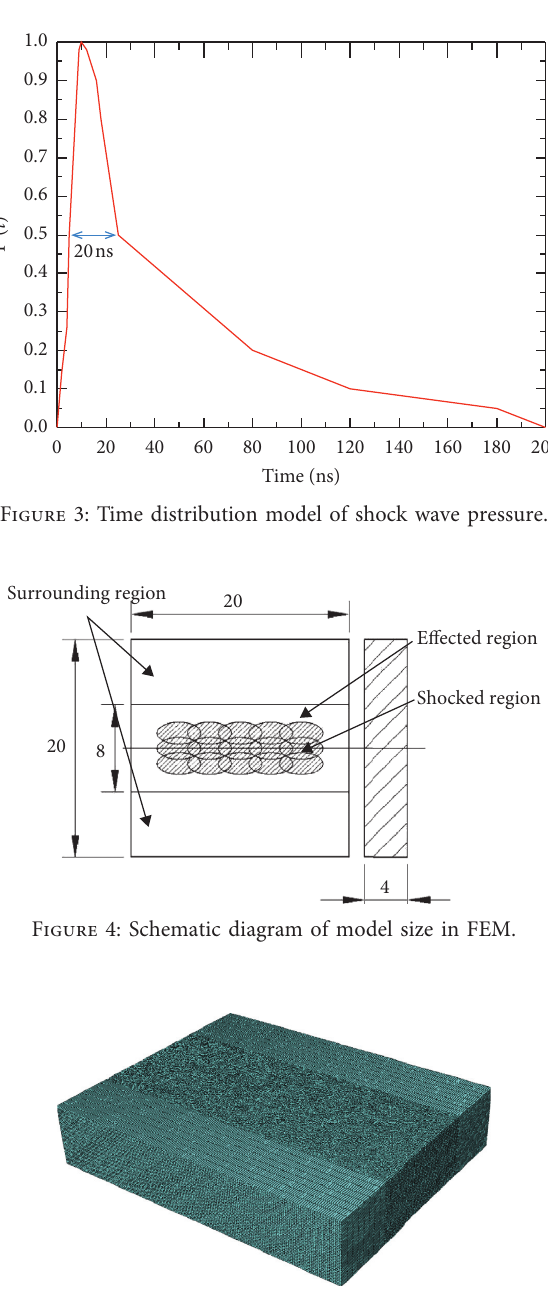
Figure 5: Schematic diagram mesh of